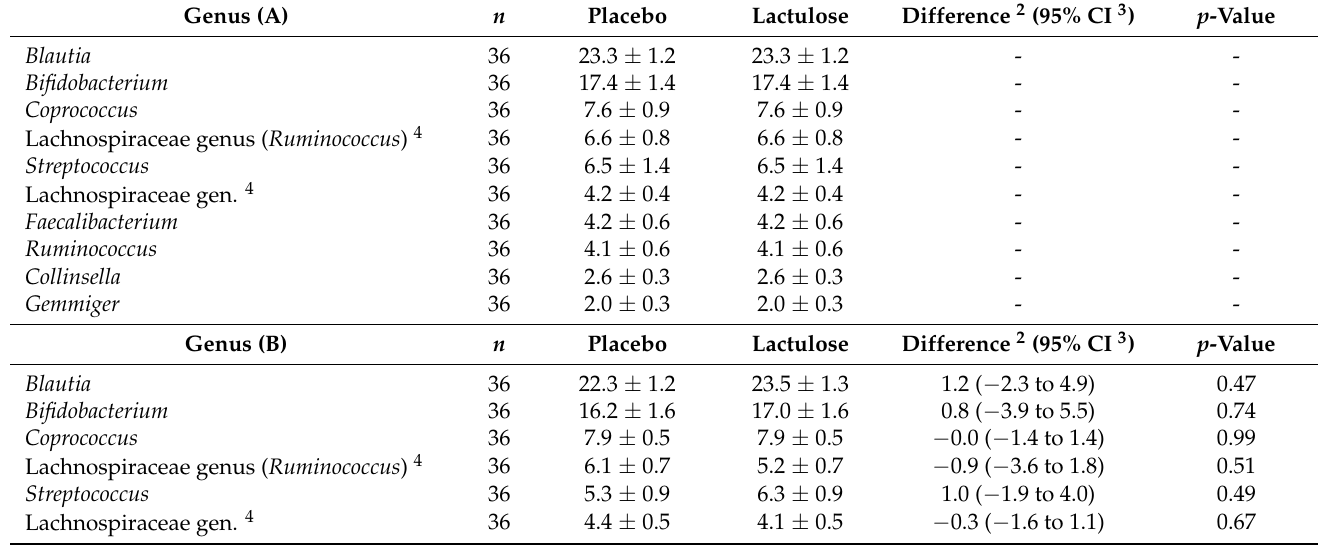
Table A1. ( A ). Percentages in the faecal microbiome before the test food intervention 1 . ( B ).